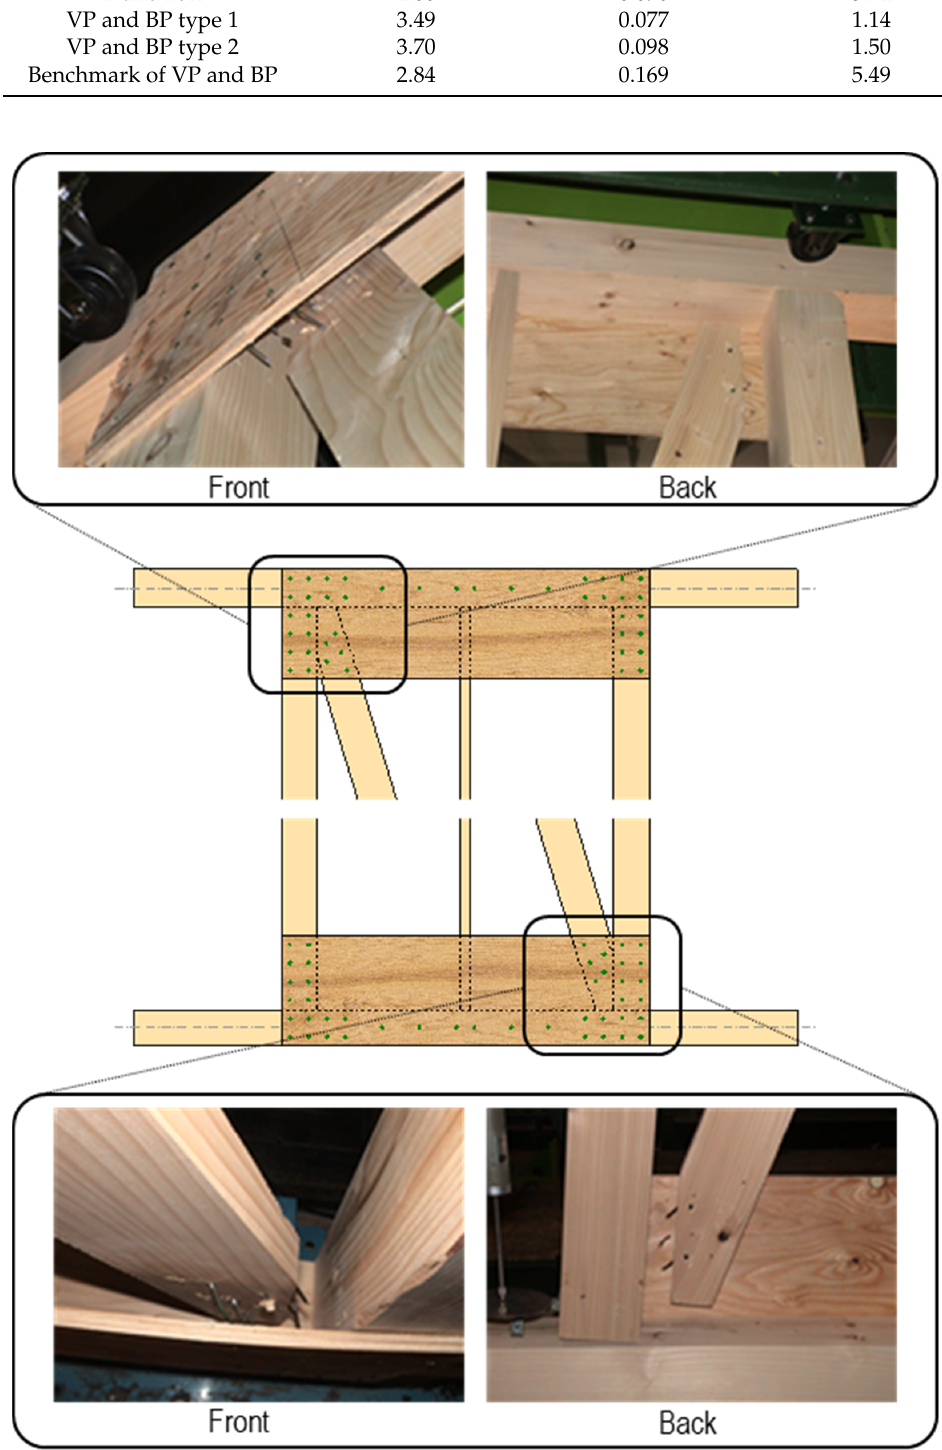
Figure 15. The ultimate failure of post-beam-brace connections in the P and N